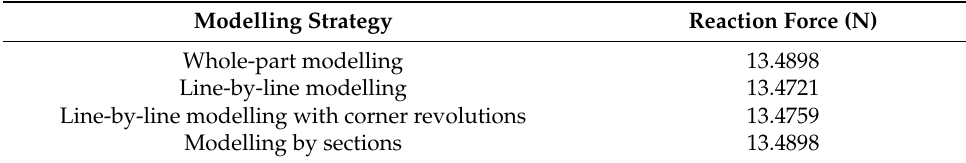
Table 4. Comparison of Simulation